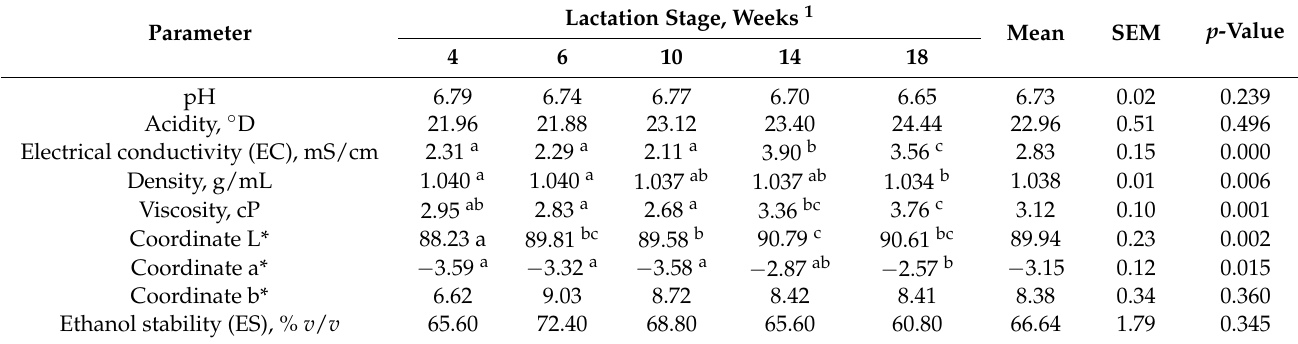
Table 4. Physical properties of red deer milk collected over the 18-week lactation